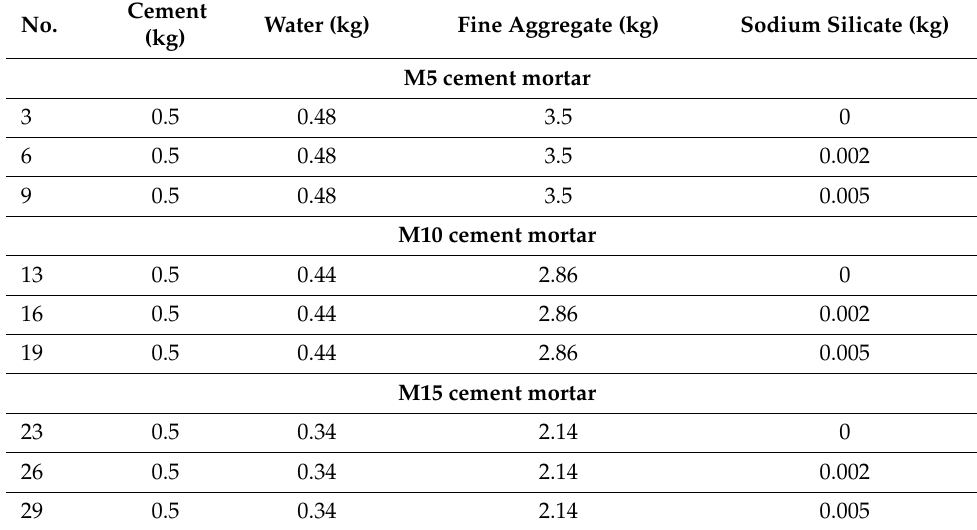
Table 4. Mix designs of the masonry